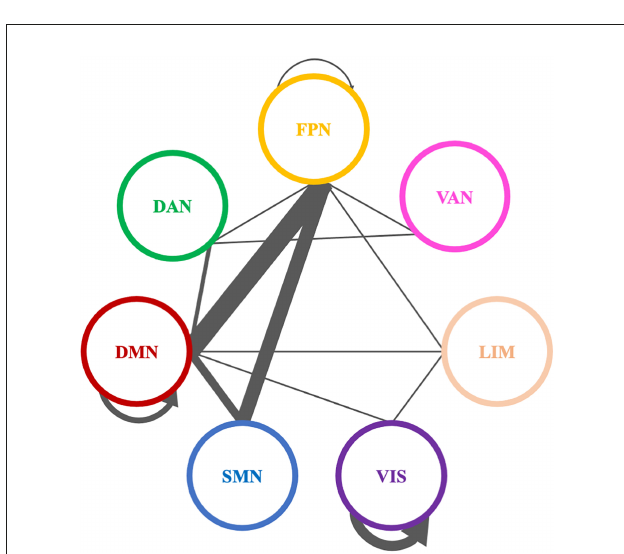
FIGURE9 Significantly modified connections of alpha PLI networks across time (T0, T1, T2), between or within the seven resting state networks (RSNs; Thomas Yeo et al., 2011). Line weight corresponds to number of significant connections. Most changes were observed in connections between default mode network, frontoparietal network, and somatomotor network or within the default mode network and the visual network. DAN, dorsal attention network; DMN, default modenetwork;LIM,limbicnetwork;FPN,frontoparietalnetwork;SMN, somatomotor network; VAN, ventral attention network; VIS, visual network.